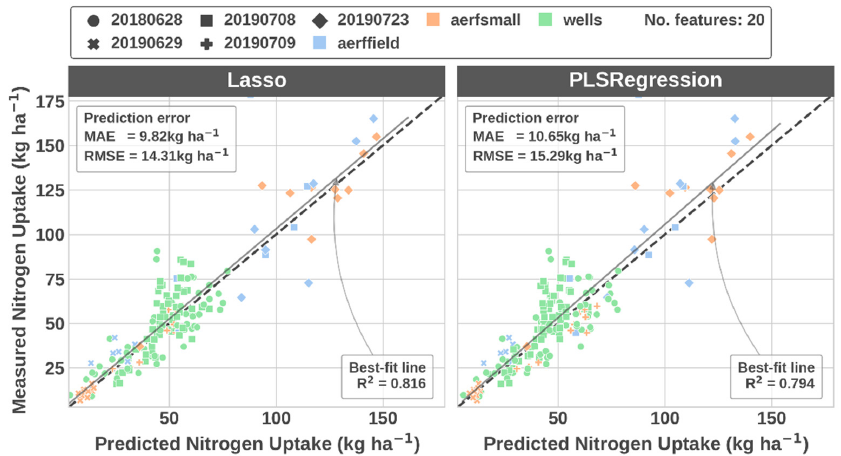
Figure A4. Measured and predicted nitrogen uptake (NUP) values from each estimator using the test dataset ( n = 163). The mean absolute error (MAE) and root mean squared error ( RMSE ) correspond to the prediction error (i.e., deviation from the 1:1 dashed line), whereas the coefficient of determination (R2) corresponds to the best-fit line.